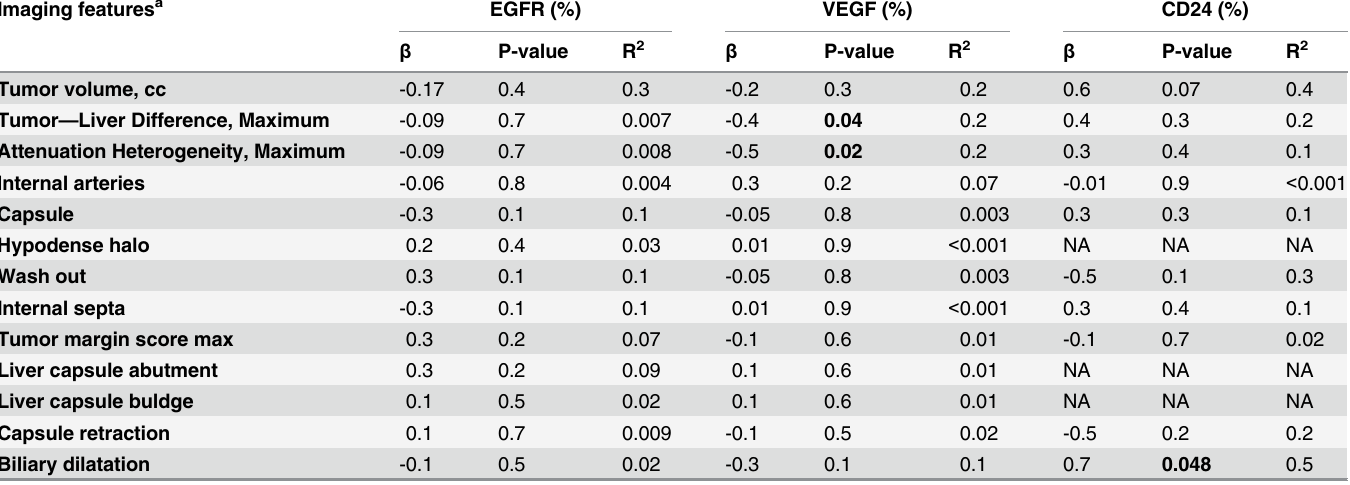
Table 2. Relationship between qualitative imaging features and protein expression levels by linear regression. Imaging features